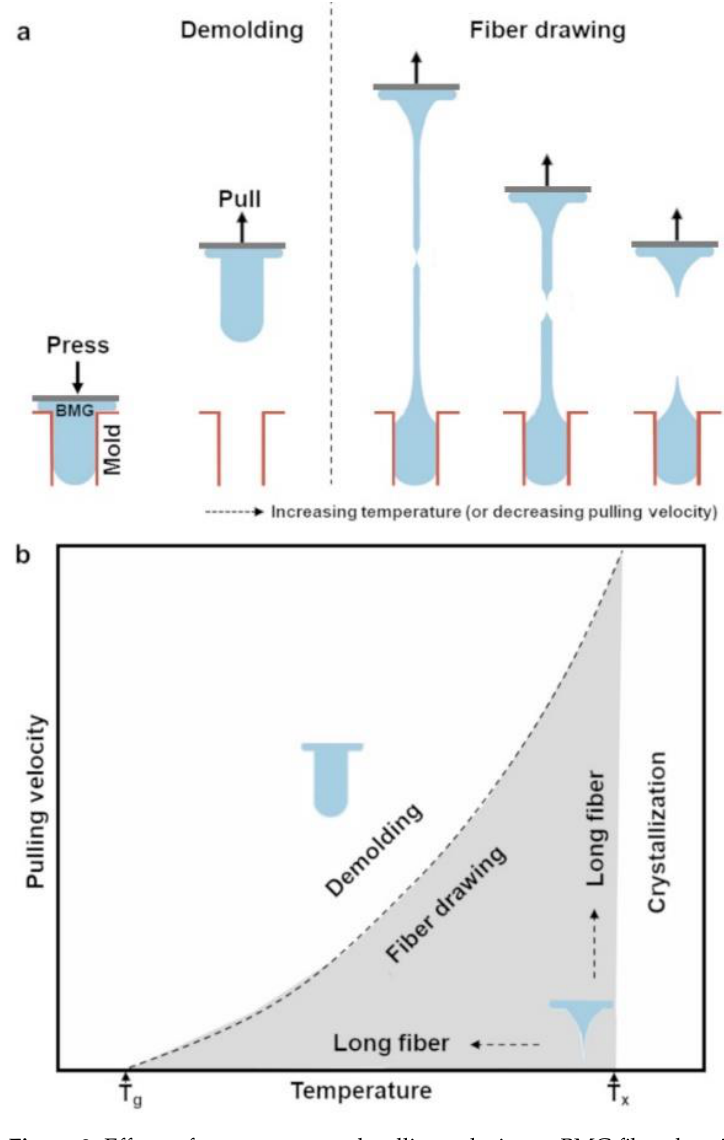
Figure 3. Effects of temperature and pulling velocity on BMG fiber drawing. ( a ) Change in morphol- ogy of BMG fiber drawn under different conditions. ( b ) Fiber drawing map in the supercooled liquid temperature range of a BMG.